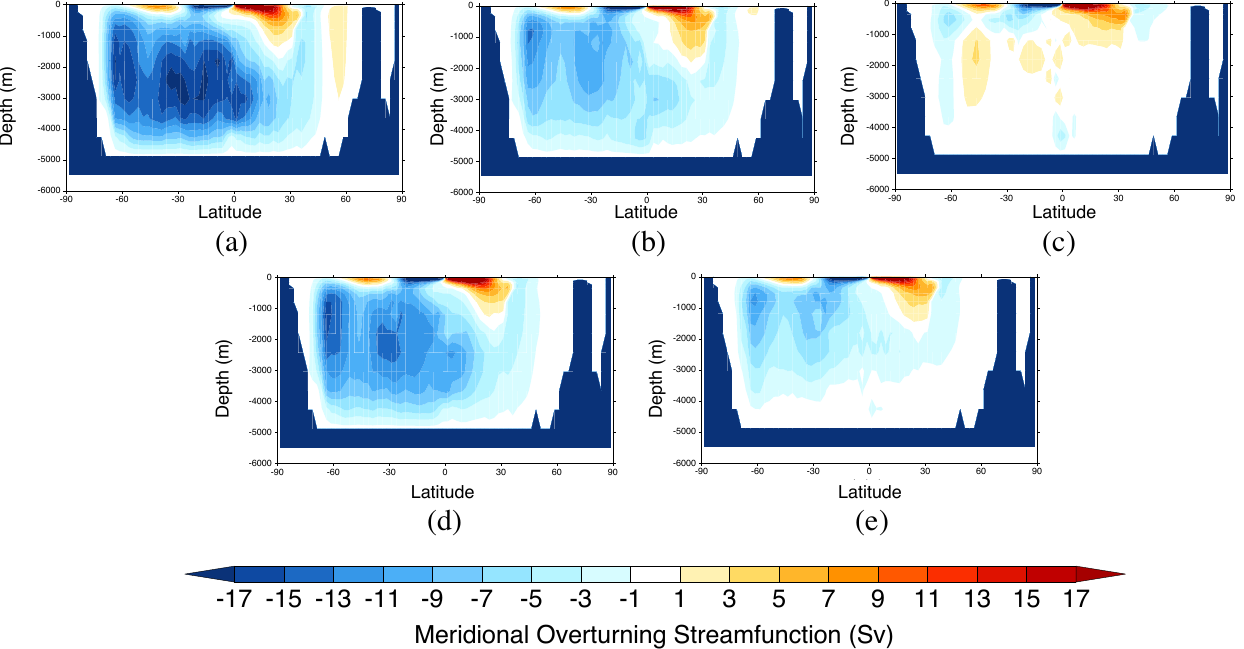
Fig. 15. Global annual meridional overturning stream function for (a) 2 × SHRUB, (b) 4 × SHRUB, (c) 4 × FIXED, (d) 2 × DYN and (e) 4 × DYN. Positive values indicate clockwise circulation and negative values indicate anticlockwise circulation.